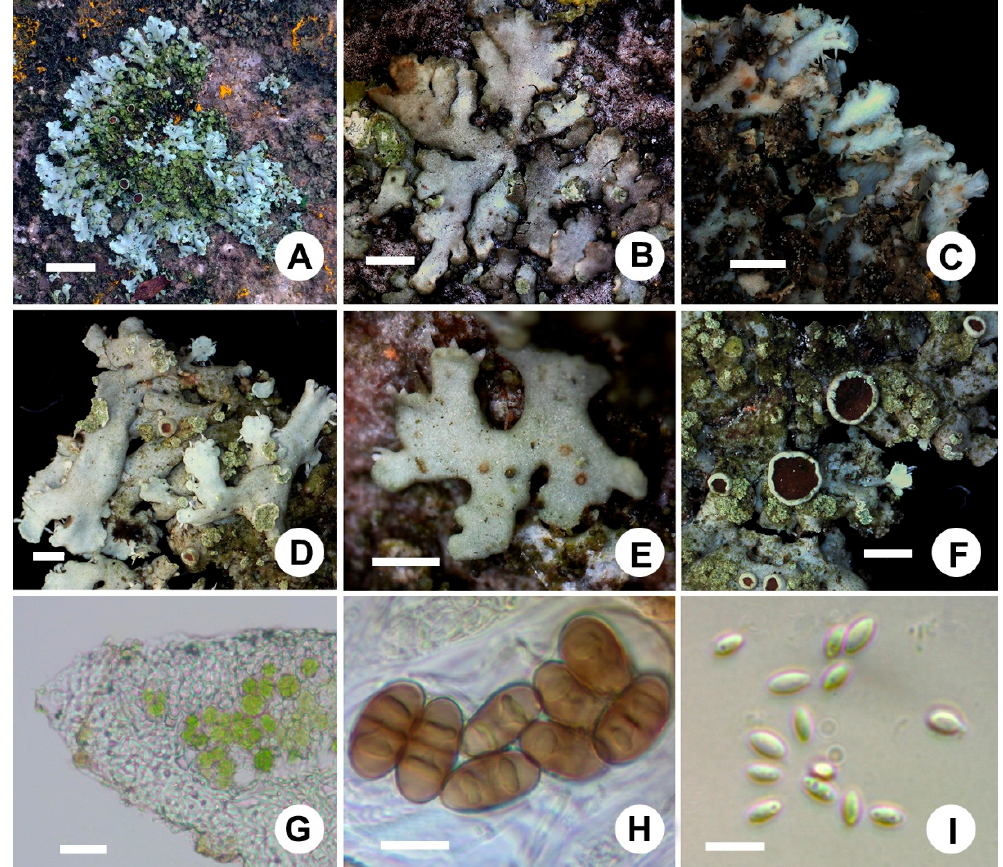
Figure 4. Physciella melanchra ( A ) on rock (D. Liu 171426), ( B ) on bark (D. Liu 171449), ( C ) white lower surface, ( D ) soralia and rhizines, ( E ) pycnidia, ( F ) apothecia, ( G ) vertical section of thallus, ( H ) ascospores in oil, and ( I ) conidia. Scale bars: (A) = 1 cm, (B) = 0.5 mm, (C) = 1 mm, (D) = 0.5 mm, (E) = 0.3 mm, (F) = 1 mm, (G) = 20 µm, (H) = 10 µm, (I) = 5 µm. Chemistry: Thallus K − ; medulla K − , C − , KC − , P − ; lacking secondary substances. Ecology: The species is found growing on rocks in South Korea, together with Phaeophyscia primaria , P. orbicularis , and P. exornatula